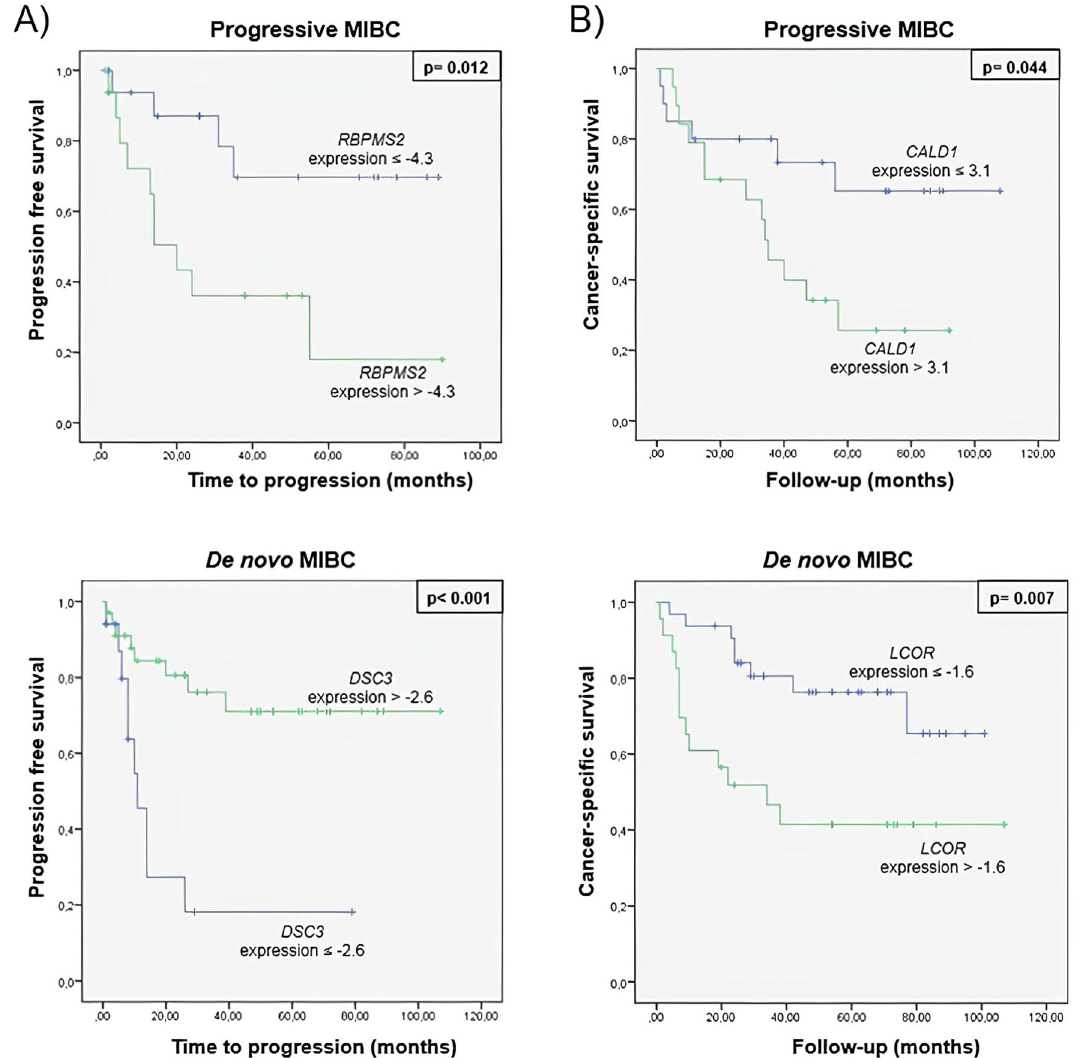
Figure 3. Kaplan–Meier curves for ( A ) tumor progression and ( B ) cancer specific survival of prognostic biomarkers in progressive and de novo MIBC